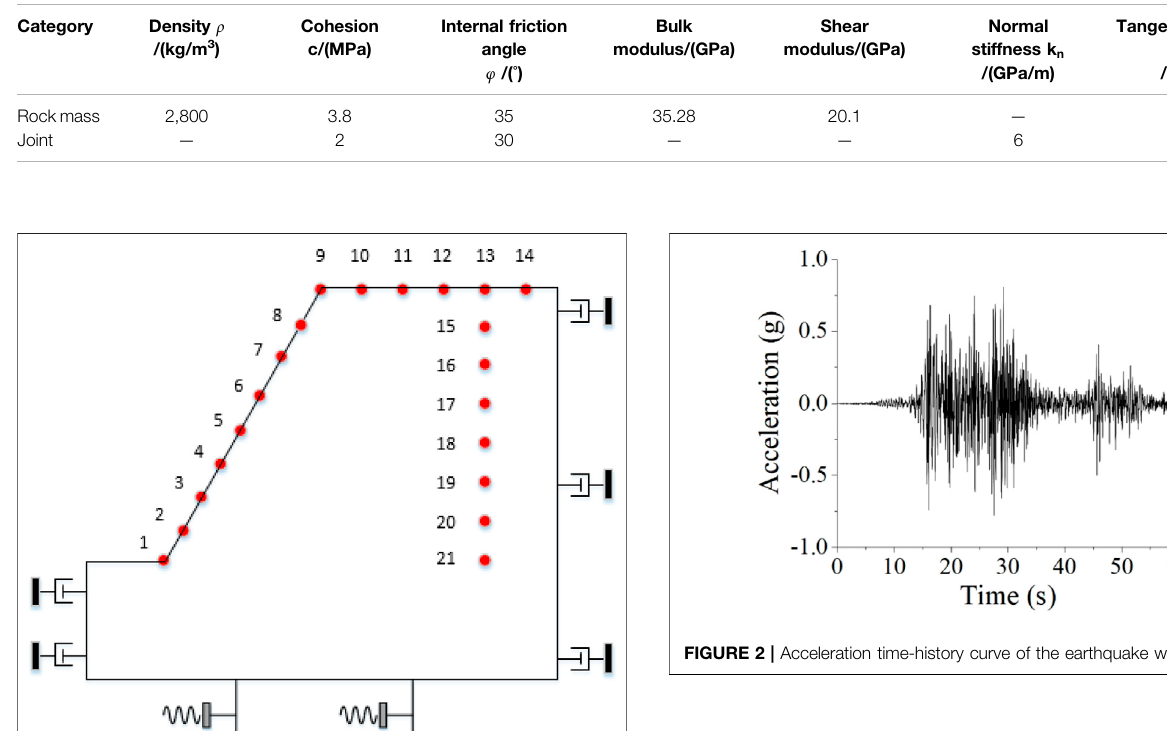
TABLE 1 | Physico-mechanical parameters of the model slope.